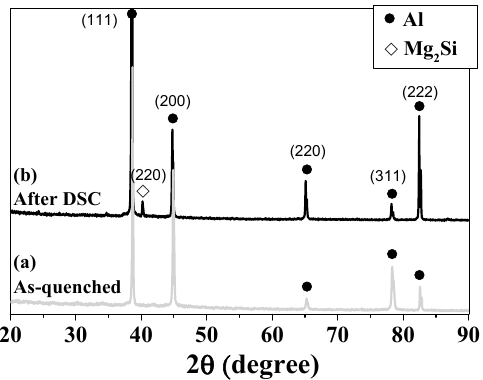
Figure 4. X-ray diffraction patterns of Al-1.9Mg2Si specimens: ( a ) as-quenched sample (supersaturated solid solution state) and ( b ) DSC analyzed sample.